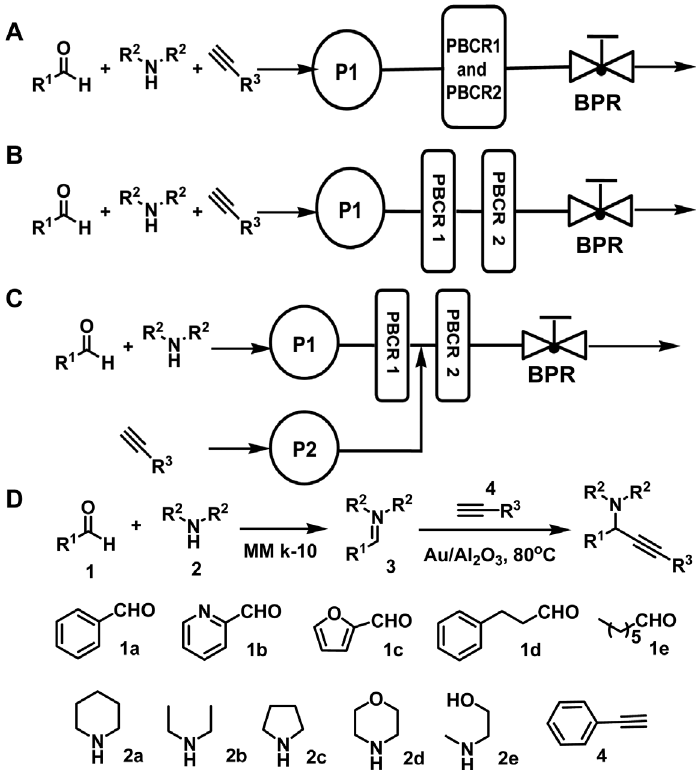
Figure 7 (A–C) Flow chemistry setup schemes for the different reaction regimes, P1 and P2: pumps; PBCR1 (MM K-10) and PBCR2 (Au-NP@ Al O ); BPR, back-pressure regulator. (D) Scheme of the A 3 -coupling reaction and the combination of the various aldehydes and amines used 2 3 in the reaction regime C. Redrawn from [69].